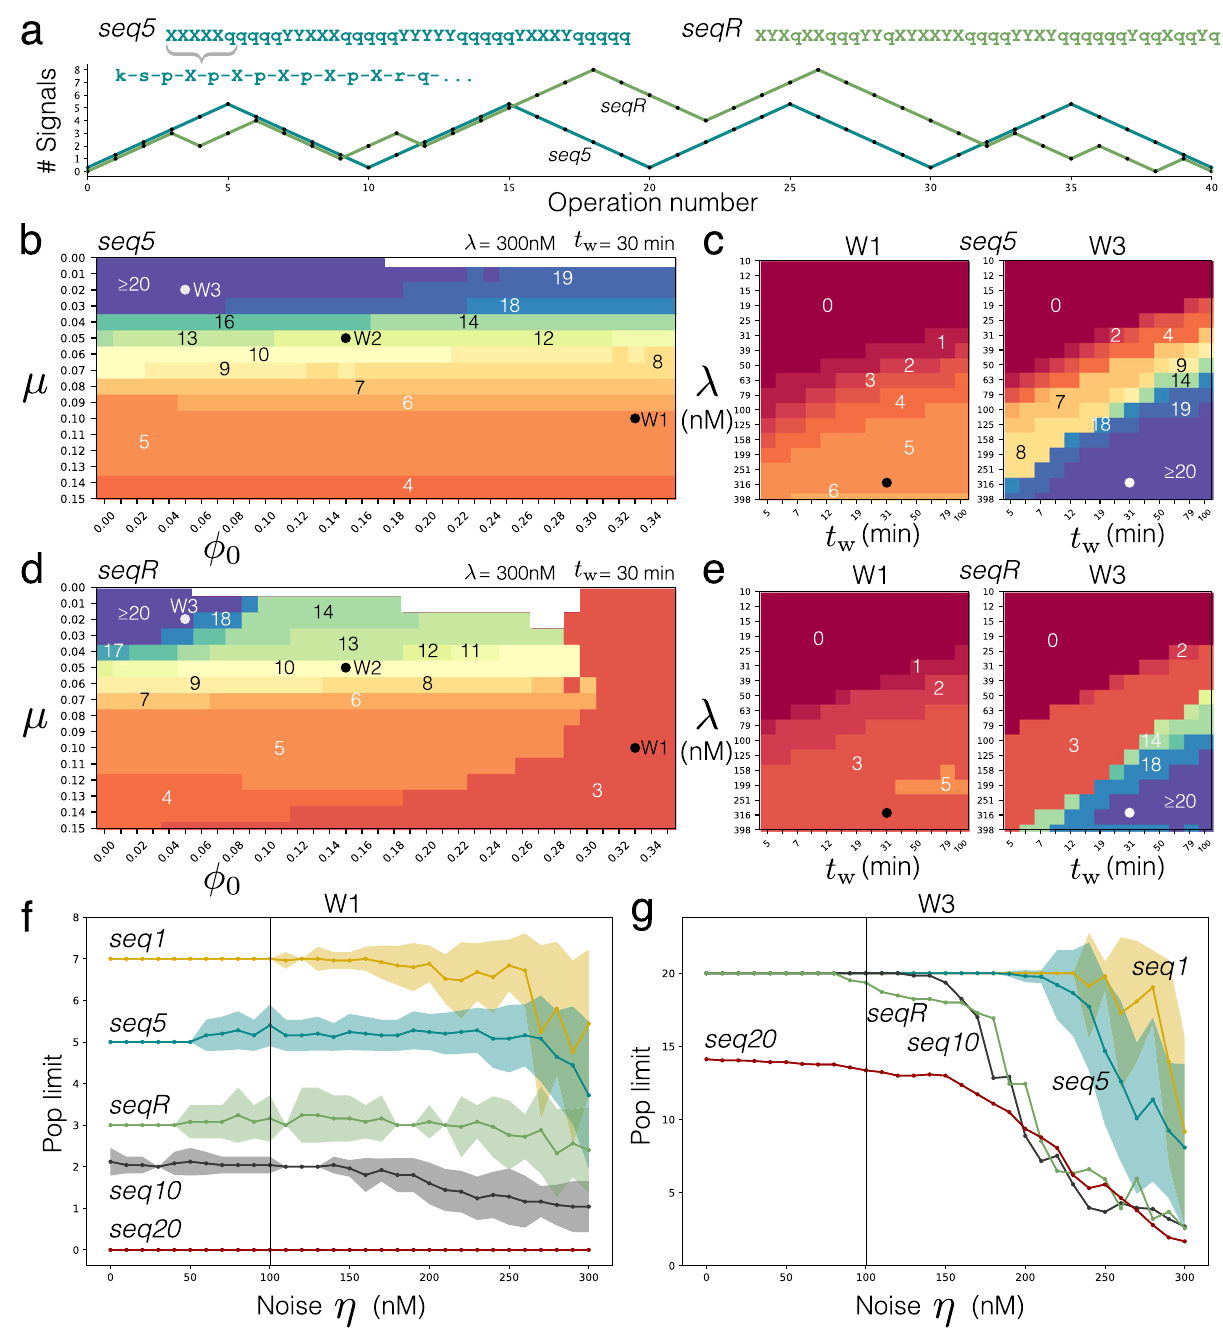
Fig. 3 Model predictions of how the pop limit of a two signal type DNA stack is affected by different factors. a Operations sequences seq5 and seqR applied to model. Pyramid graph shows how stack elongates/truncates over time (total signals on stack) under each sequence (ideal operation). Heat maps b and d show how stack pop limit is sensitive to washing procedure ef fi ciency for seq5 and seqR respectively. Pop limit is denoted by overlaid numbers on heat map surface contours. Each heatmap square is a single simulation. Heat maps c and e show how pop limits vary at points W1 and W3 on ( b ) and ( d ), respectively, when strand concentrations λ and reaction wait times t w deviate from standard conditions 300 nM and 30 min. Dots on heatmaps indicate position of standard conditions. Note the log scales. f How pop limit is affected by pipetting noise under W1 washing. Pipetted concentration is drawn from uniform distribution 300 nM ± η . Average pop limit (lines) calculated from n = 25 independent stochastic simulations performed at each noise value, standard deviation shown as line shadows. g Same as f but using W3 ef fi cient washing: overlapping lines seqR , seq10 , and seq20 omit standard deviation shadows (drawn in Supplementary Note of 3.4 signals correctly popped per operations sequence, before Heatmaps in Fig. 3c, e show the predicted stack performance on output can no longer be discerned. This value generally agrees seq5 and seqR , for washing ef fi ciencies W1 and W3, when with our experimental observations of the two signal DNA stack concentrations and reaction wait times are changed from the system (see below). standard γ = 300 nM and t w = 30 min, respectively. See